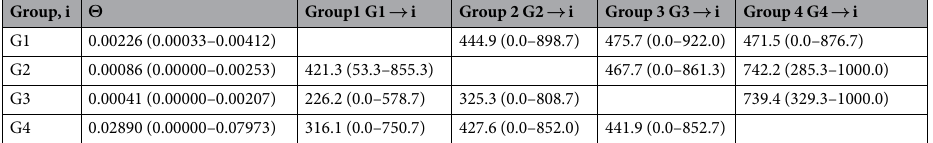
Table 4. Estimates of gene flow between four Corythucha ciliata groups based on concatenated mtDNA sequences. Θ : mutation scaled effective population size; M: mutation scaled effective immigration rate. In parentheses the 95% HPD intervals. The source population is indicated in columns, the target population in